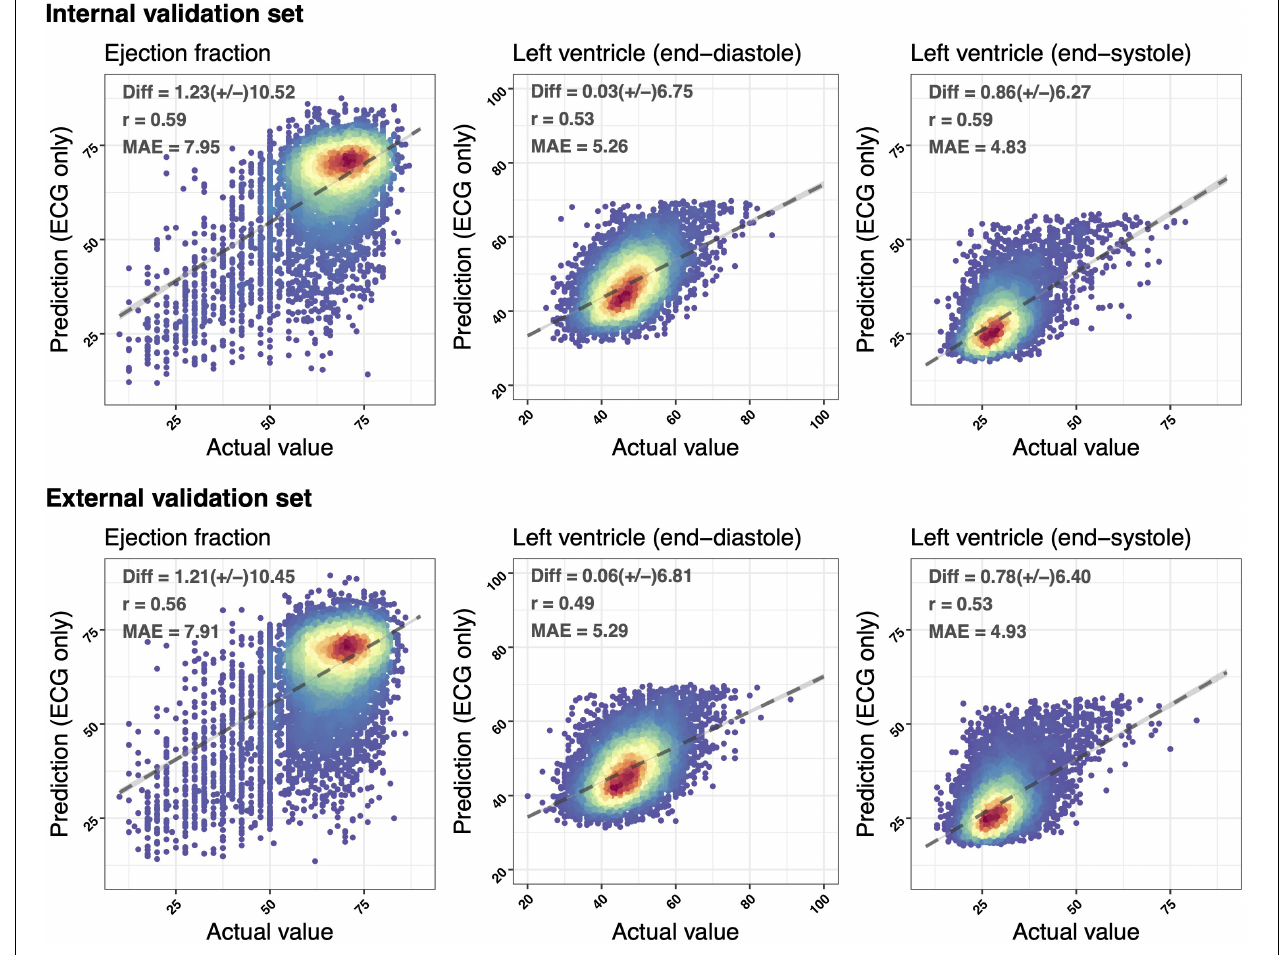
FIGURE 2 | Scatter plots of predicted value via ECG voltage–time traces only compared with the actual ejection fraction (EF) and left ventricle (end-diastole/end-systole) (LV-D/LV-S). The x -axis indicates the actual value and the y -axis presents the ECG-predictions. Red points represent the highest density, followed by yellow, green light blue, and dark blue. We presented the mean difference (Diff), Pearson’s correlation coefficients ( r ), and mean absolute errors (MAEs) to demonstrate the accuracy of a deep learning model (DLM). The black lines with 95% conference intervals ( CI s) are fitted via simple linear